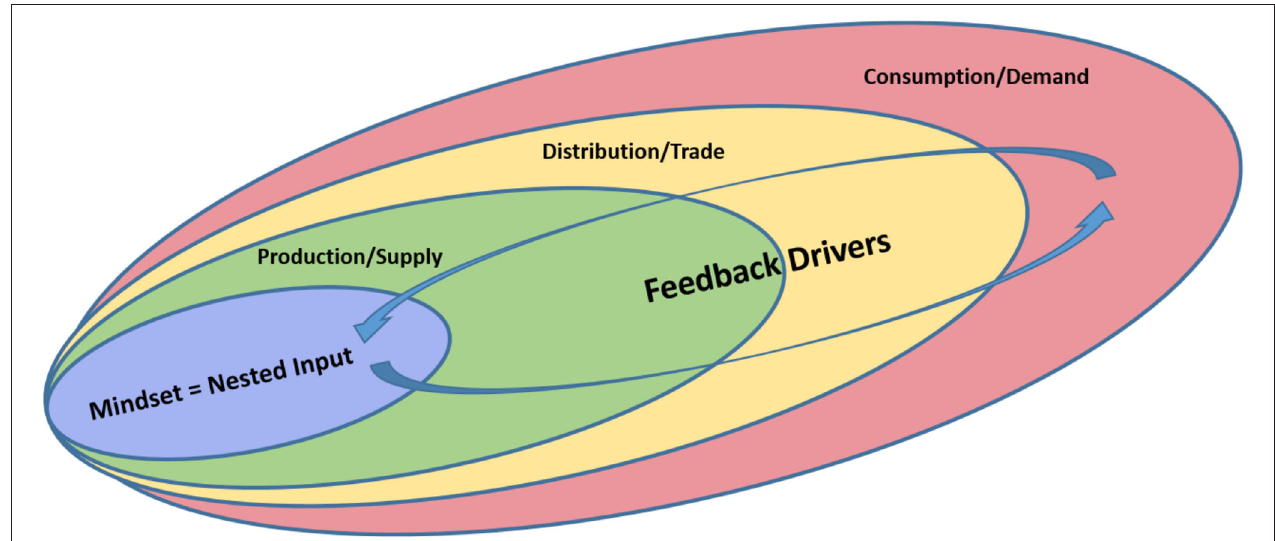
FIGURE 1 | Mindset as encapsulated, omnipresent input to food systems, manipulating leverage points and inextricably intertwined with feedback by determining its driving quality across the system.